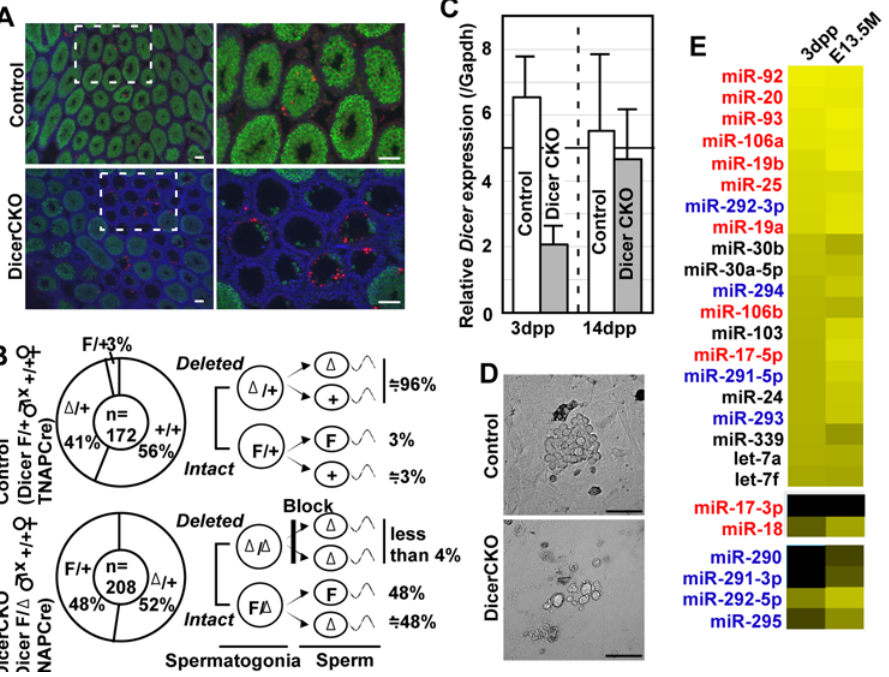
Figure 4. Crucial roles of Dicer on spermatogenesis. (A) Immunofluorescence analysis for Mvh (green), apoptotic cells (red) and nuclei (blue) in 4 weeks-old DicerCKO testis. Right images show high magnification of white broken rectangles in left images. Scale bar: 50 m m (B) Biased inheritance of floxed dicer allele by progeny from DicerCKO males. Pie charts summerise percentages of genotypes of progeny from Dicer F/ + TNAP-Cre (upper) and DicerCKO (bottom) males crossed with wild-type females. The number of progeny tested is shown in the center of the circles. Note that intact floxed dicer allele (F) is frequently inherited by progeny from DicerCKO males. Illustration in the right side of the pie charts estimates schematic ratio of Dicer excision in spermatogonia and spermatozoa, based on the percentages in the pie charts. Since floxed dicer allele is inherited by almost half of progeny from DicerCKO males, almost all fertile spermatozoa seems to be derived from Dicer F/ + spermatogonia which had escaped from Dicer excision, indicating blockage of spermatogenesis of Dicer -deleted cells. (C) Expression levels of Dicer in neonatal spermatogonia and 14 dpp spermatocytes. Relative expression levels of Dicer were calculated by reference to the levels of Gapdh . (D) Representative colonies derived from neonatal testis after culture for 2 weeks. Scale bar; 50 m m (E) The list of miRNA highly expressed in neonatal spermatogonia. MiRNAs encoded in miR- 17-92 and miR-290-295 clusters are marked with red and blue, respectively. The miRNA levels detected by real-time PCR are represented as a heat map. The intensity of yellow scale corresponds to the level of miRNA expression; black indicates that the signal below detection levels (see in Figure 1A).